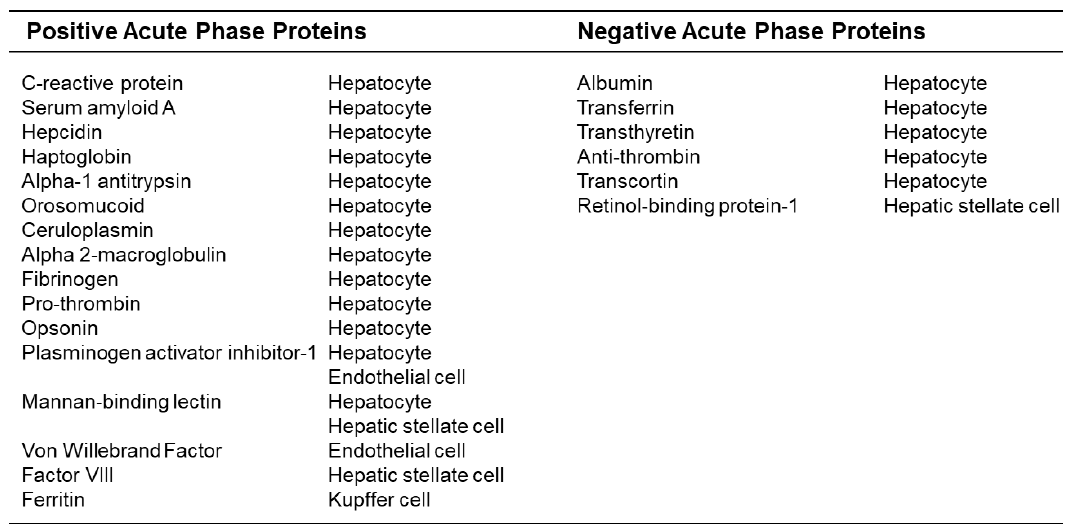
Figure 1. Liver-derived proteins associated with the acute phase response. Acute phase proteins are defined based on a change in plasma concentration of at least 25 percent in the setting of an inflammatory disorder. Shown are proteins that increase (positive acute phase protein) and decrease (negative acute phase protein) during an acute phase response. Also displayed is the predominant cellular source for each protein.